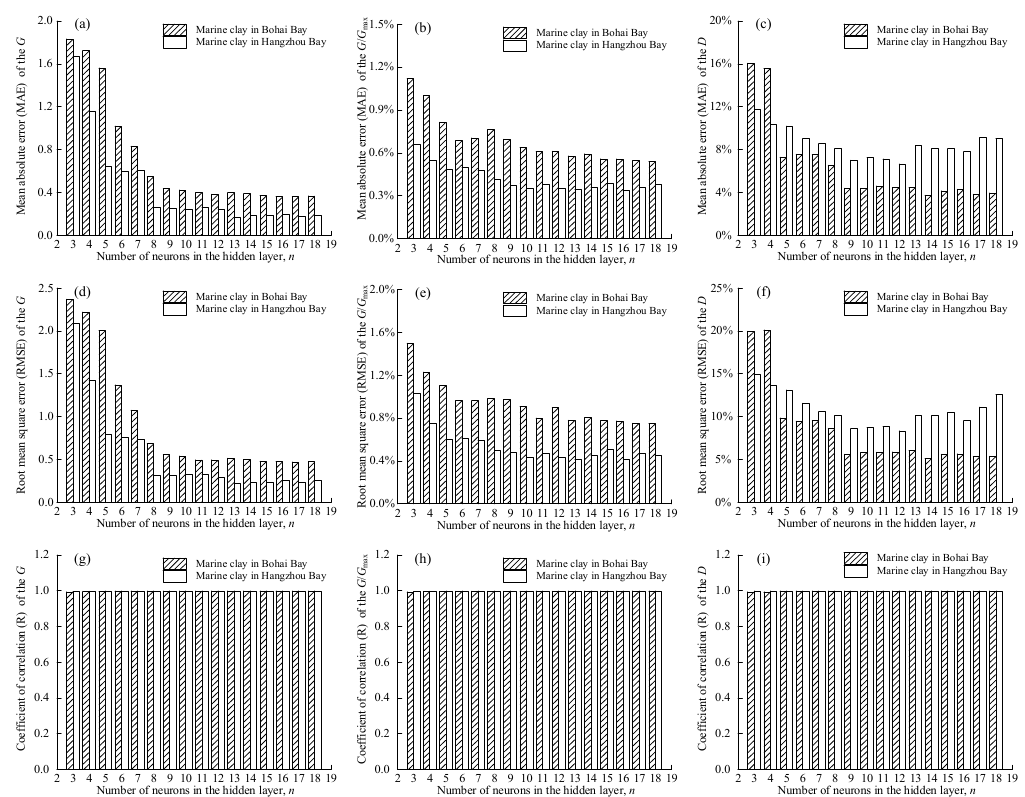
Figure 7. Prediction performance of the intelligent model with different n: ( a – c ) the MAE of G , G / G max , and D for marine clays; ( d – f ) the RMSE of G , G / G max , and D for marine clays; ( g – i ) the R of G , G / G max , and D for marine clays.